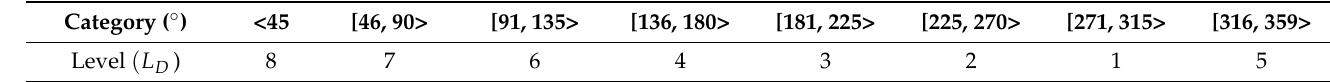
Table 5. Wind direction categories.